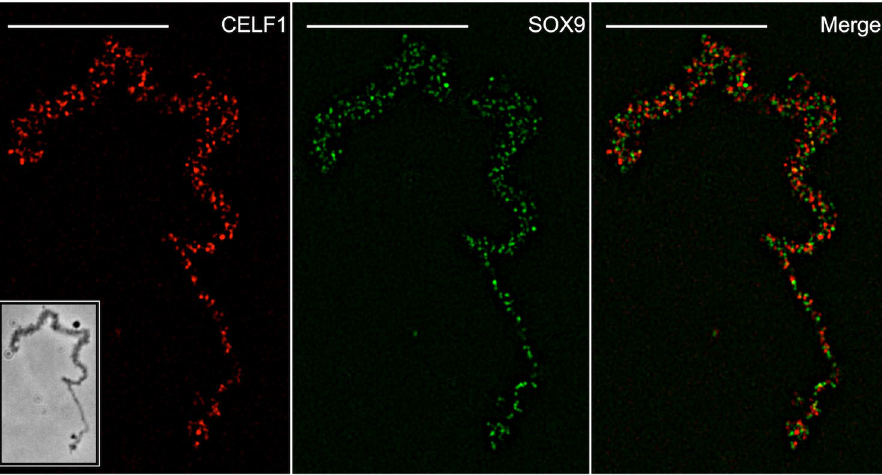
Figure 7. Super-resolution images of a P. waltl lateral loop immunostained for CELF1 [mAb3B1 (red, Alexa 568 IgG)] and SOX9 [anti-Cter-SOX9 antibody (green, Alexa 488 IgG)]. The RNP matrix exhibited a pattern of granules immunostained for SOX9 and CELF1. The merged panel showed that the SOX9 and CELF1 granules did not colocalize. The intensity of fluorescence in the different experiments was normalized with respect to their relevant controls with the secondary antibodies alone. Structured Illumination Microscopy (SIM). The image in the boxed area corresponded to the phase contrast image obtained from Wide field Leica microscopy. Scale bar: 10 μ